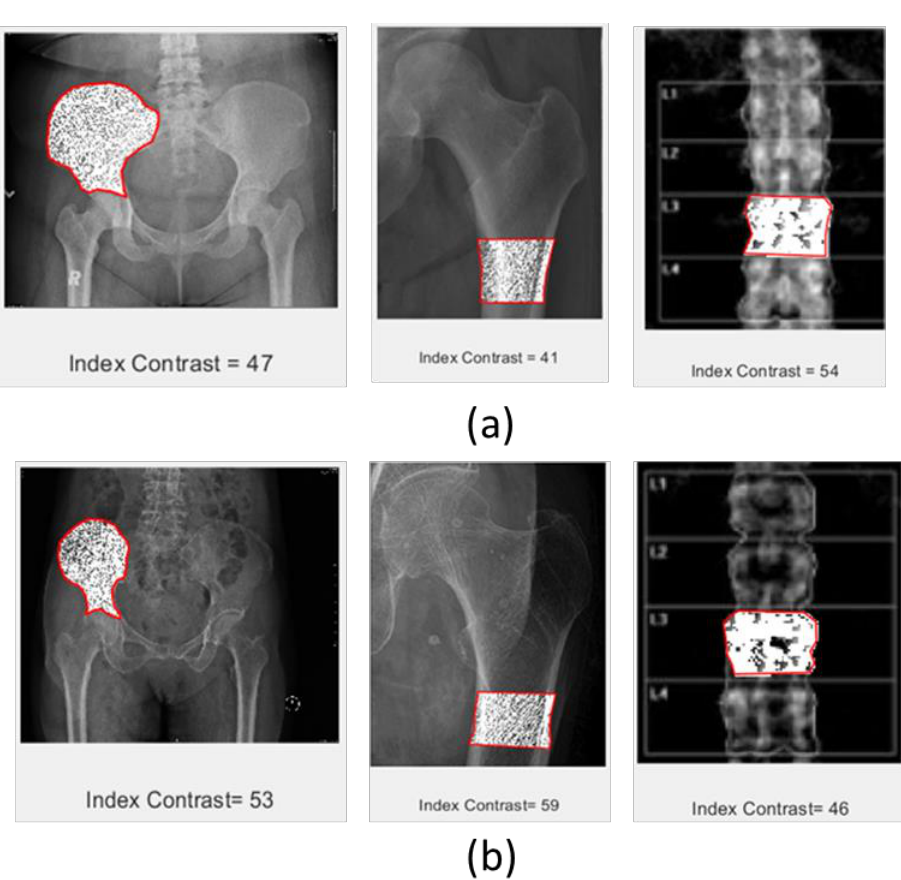
Figure 7. Contrast index of different image data of pelvic (left), hip (middle), and lumbar spine (right); ( a ) normal bone and ( b ) osteoporotic bone, a red box indicates a selected ROI .